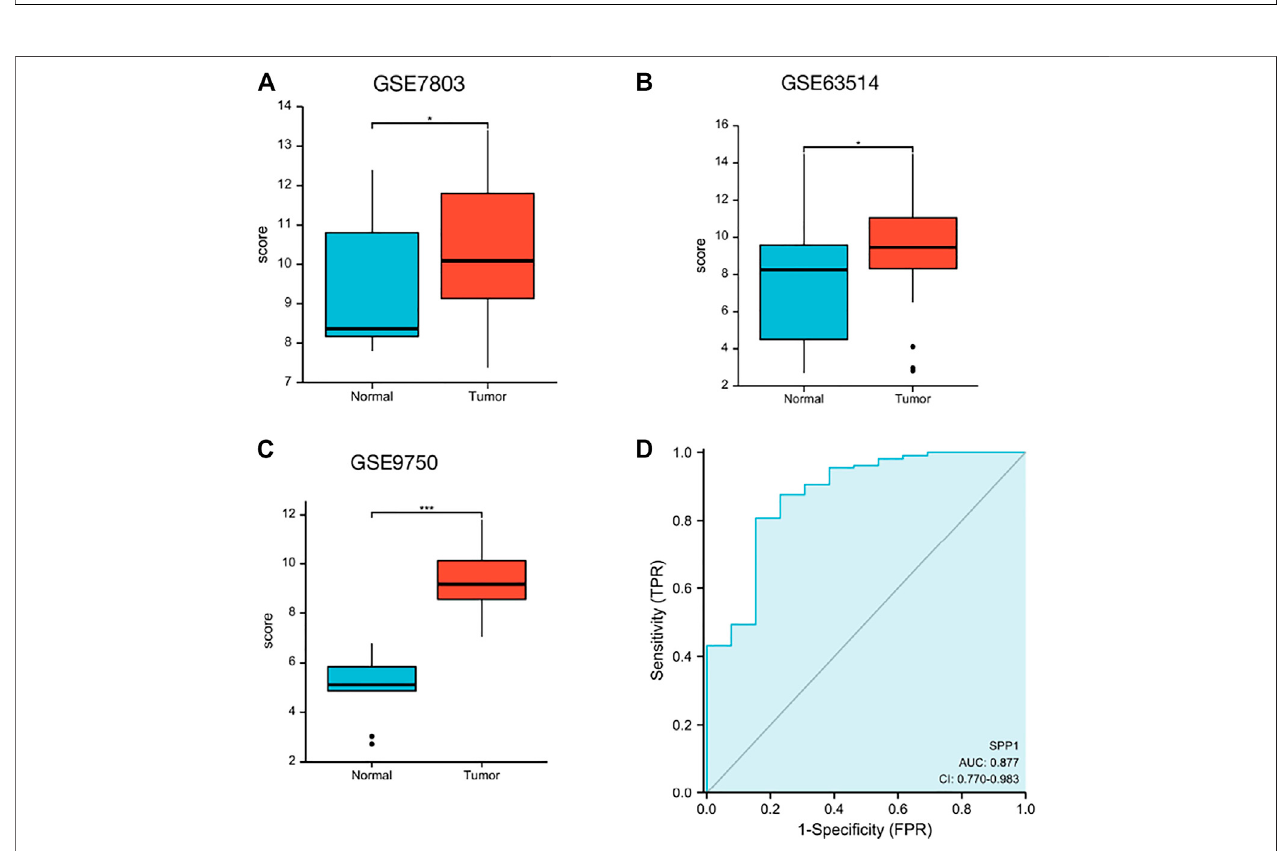
FIGURE 2 | SPP1 expression in the GEO database. (A) SPP1 expression in normal and tumor tissues in cervical cancer from GSE7803. (B) SPP1 expression in normal cervical epithelial and cervical cancer tissues from GSE63514. (C) SPP1 expression in normal cervical tissues and cervical cancer epithelial component from GSE9750. (D) ROC curve of SPP1 in cervical cancer. X -axis represents false-positive rates, and Y -axis represents true-positive rates.